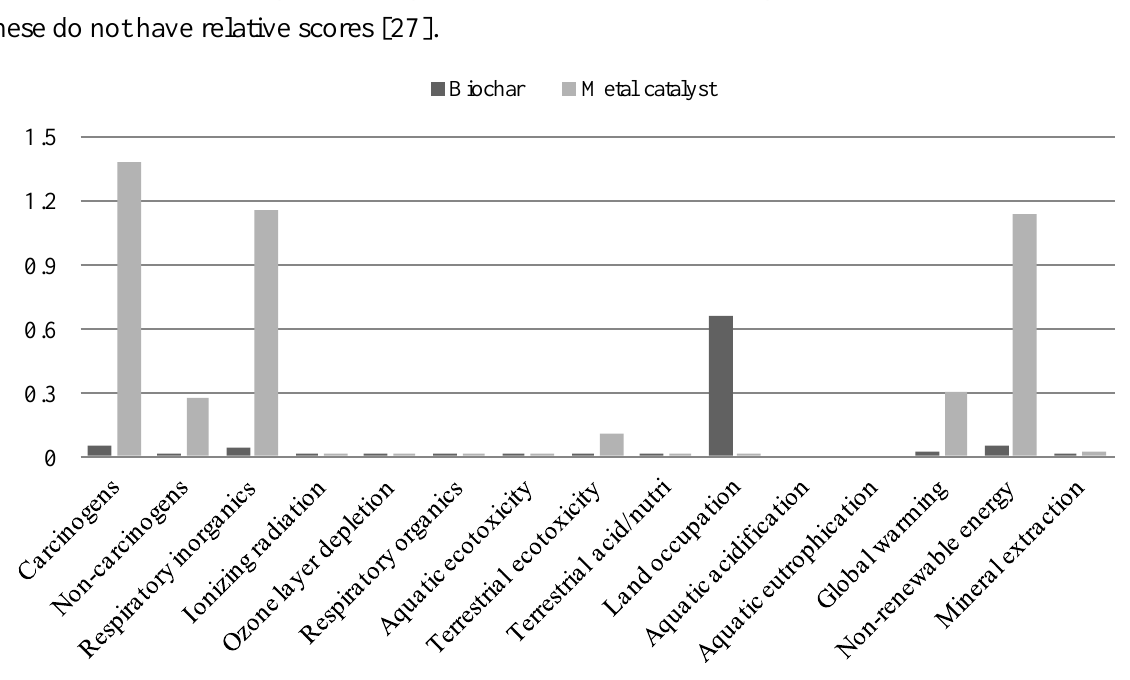
Figure 5. Comparison of LCA results expressed as single scores